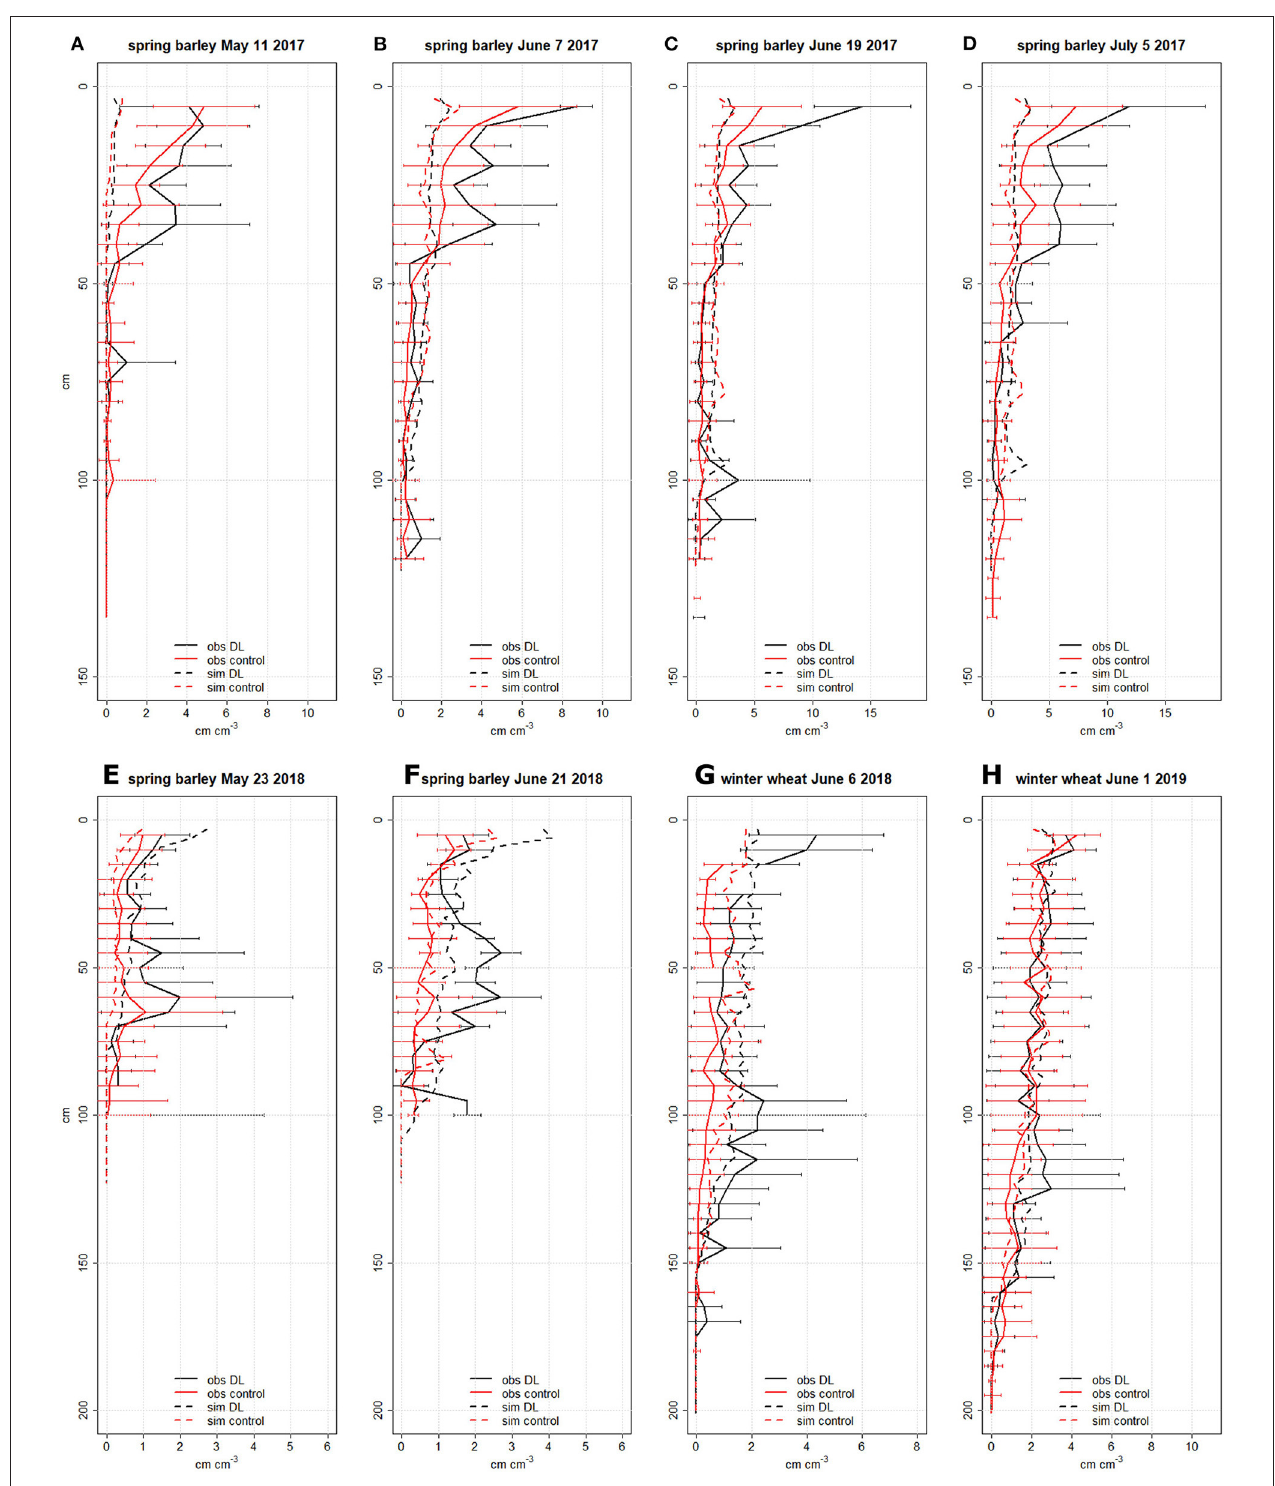
FIGURE 1 | Observed (mean and standard deviation) and simulated (SIMPLACE-CRootbox) absolute root length densities (RLDs) over soil depth in cm cm − 3 of spring barley in 2017 (top panel [A–D] ) and 2018 (bottom panel [E,F] ) and winter wheat (2018 and 2019, bottom panel [G,H] ) for the control and deep loosening (DL) (at strip) treatments. The RLD data were observed at profile walls and converted to absolute values based on profile wall and monolith data. The RLD data observed with the profile wall method were partly published in Jakobs et al. (2019).